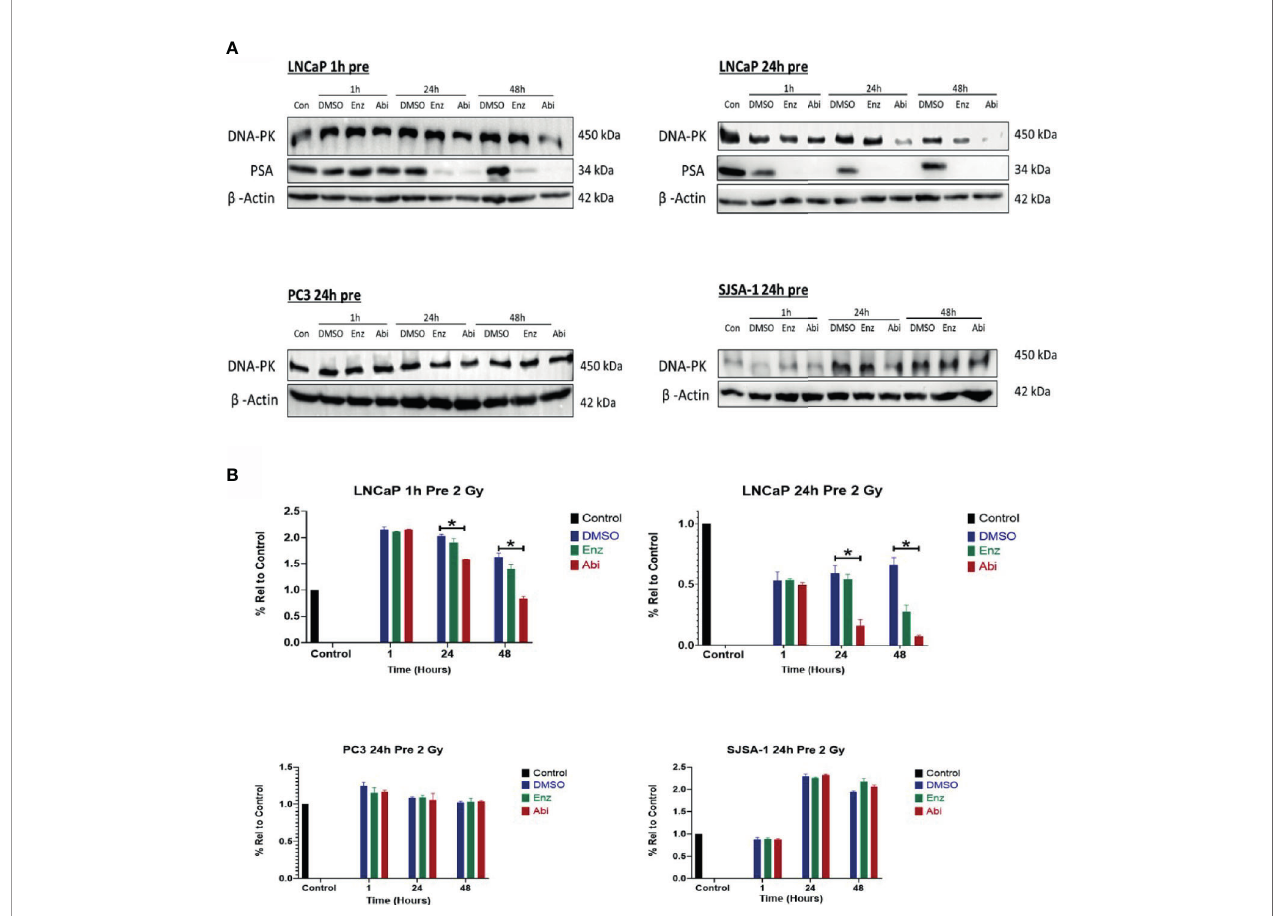
FIGURE 10 | Impact of Abiraterone and Enzalutamide in combination with 2 Gy X-ray on DNA-PK and PSA expression in AR-insensitive PC3s, AR-sensitive LNCaP prostate models and osteoblastic bone model SJSA-1. All models were treated with 10 m M Abiraterone, Enzalutamide or DMSO for 1 or 24 hours before being administered 2 Gy radiation. Samples were then harvested 1, 24 and 48 hours post-radiation and expression levels measured via Western blot (A) and densitometric analysis (B) . b -Actin was used as a loading control. (n=3). Unpaired students t-test was used for comparisons between two groups *p < 0.05 and error bars represent